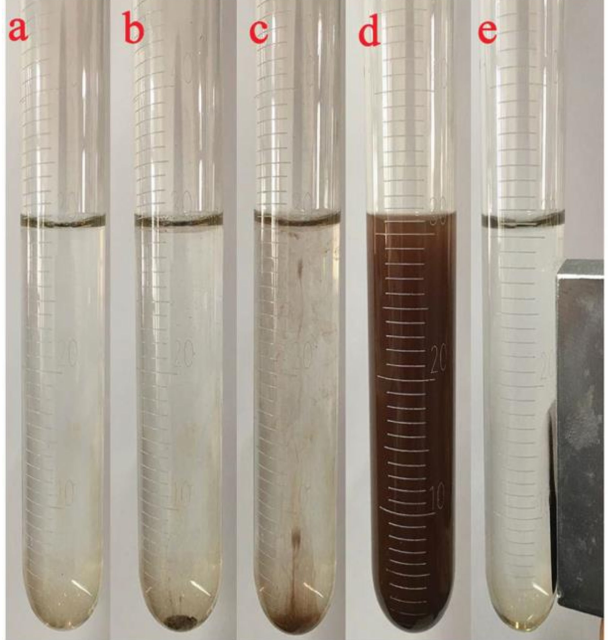
Figure 2. ( a ) A total of 30 mL of the pretreated sample is added into a 50 mL glass tube; ( b )